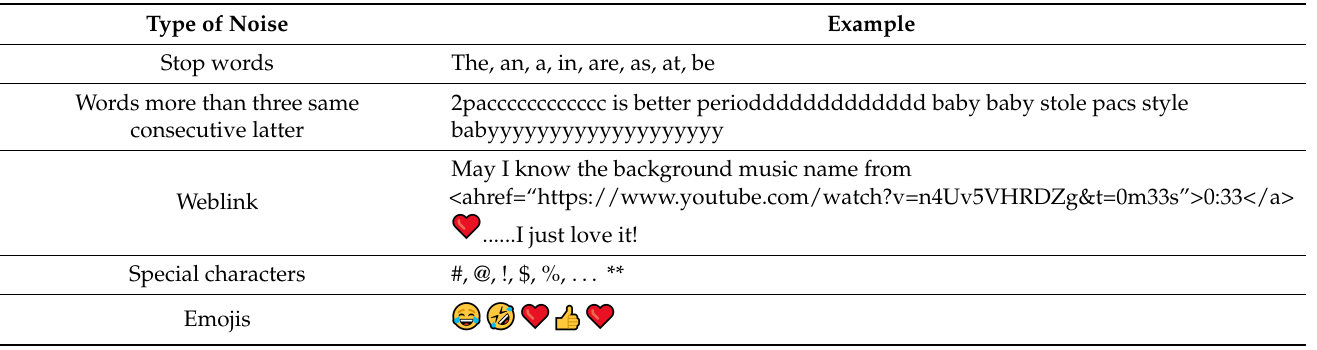
Table 3. Example of types of noise in the review comments.